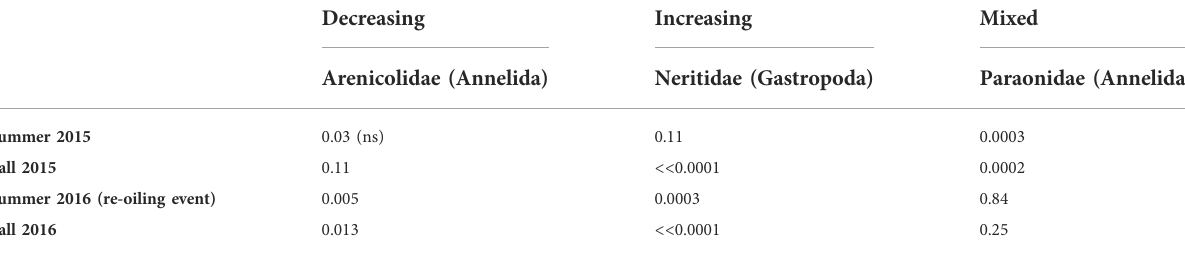
TABLE 5 Summary of Kruskal – Wallis p -values for site differences for individual taxon abundances that could not be adjusted for normality. Full Kruskal – Wallis tables are in Supplementary Appendix S3.When a p < 0.05 is marked (ns), this indicates that the p -value should not be considered signi fi cant after applying the Benjamini – Hochberg procedure (Supplementary Table